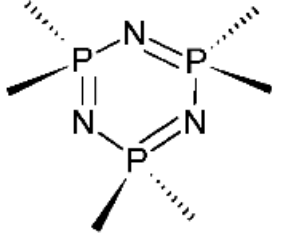
Figure 4. Arrangement of the substituents on the P atoms of the cyclotriphosphazene ring. Changes in the molecular parameters of cyclophosphazenes have been studied as a function of substituents at fixed positions, observing specific trends. As an example, the progressive substitution of chlorine atoms in the HCCP structure with HNBu t moieties increases the P-N bond lengths involving the P atom bearing the substituents and the remaining P-Cl bonds